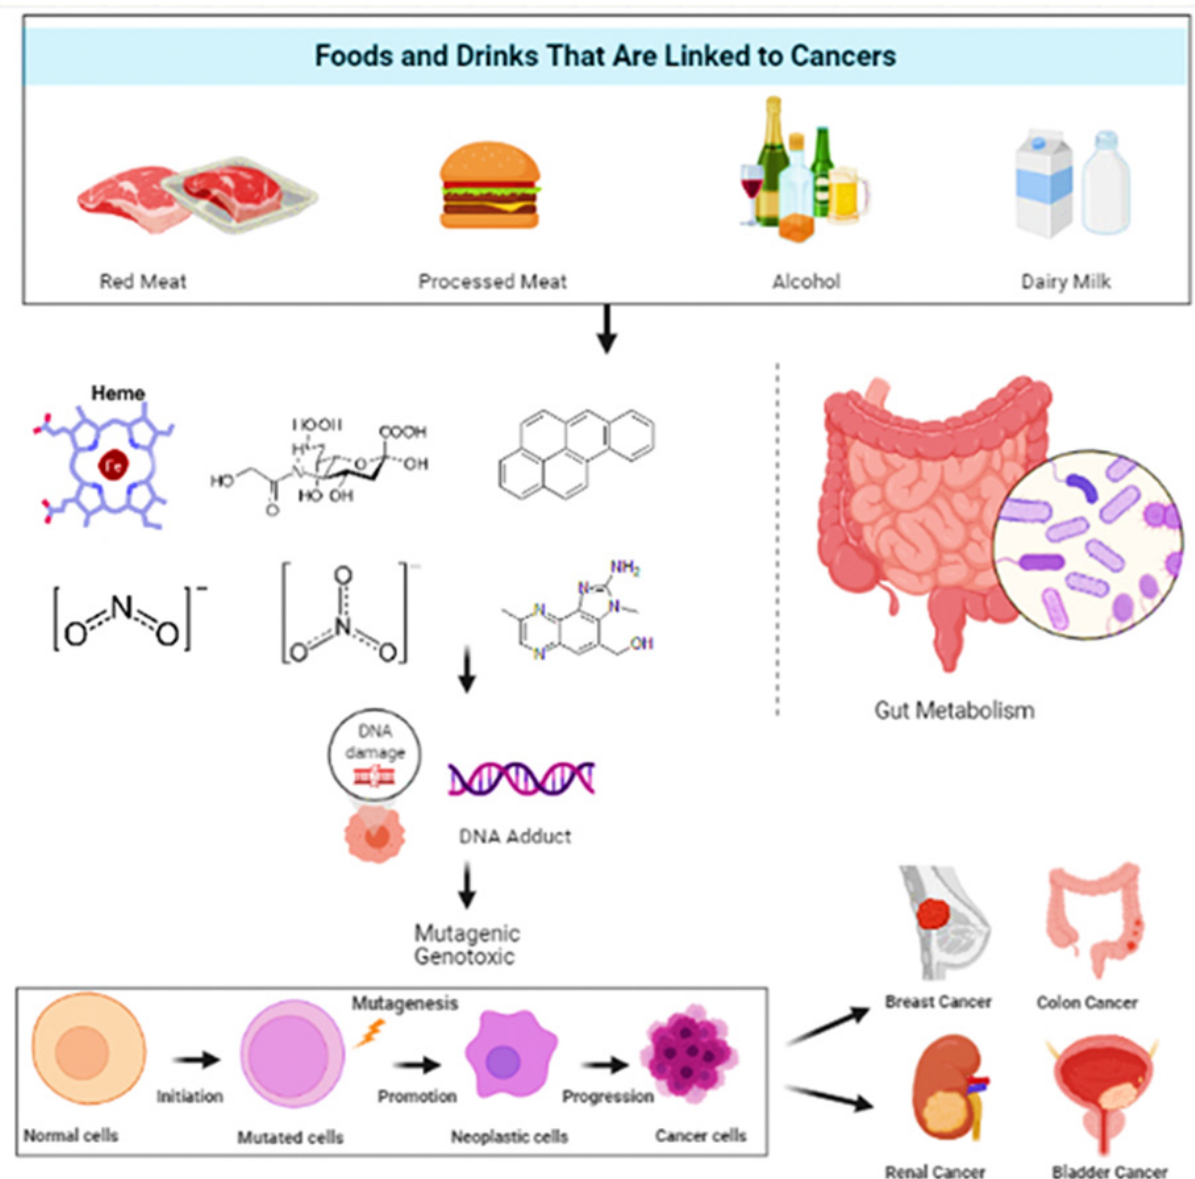
Figure 1. A pictorial representation of the types of food and their effect on selective